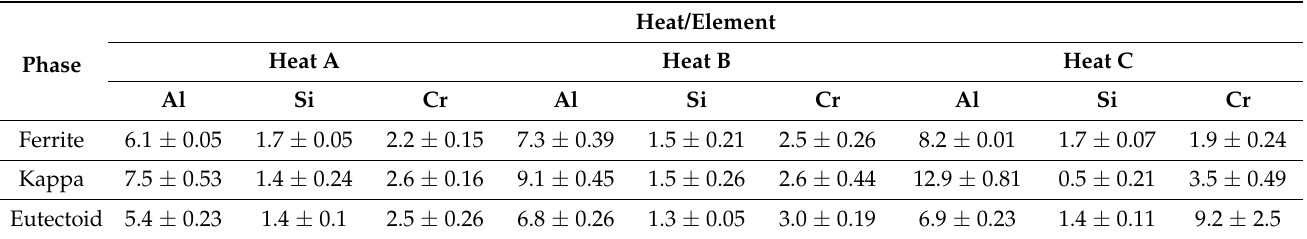
Table 4. Results of the spot analysis of the chemical composition of individual phases or mixtures. All in wt%.